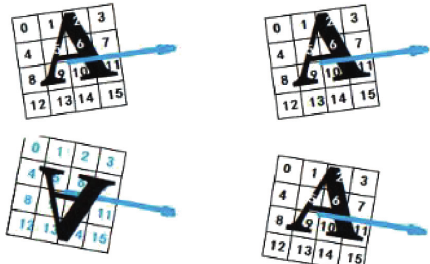
Figure 18: Flipping image (left) and rotation image